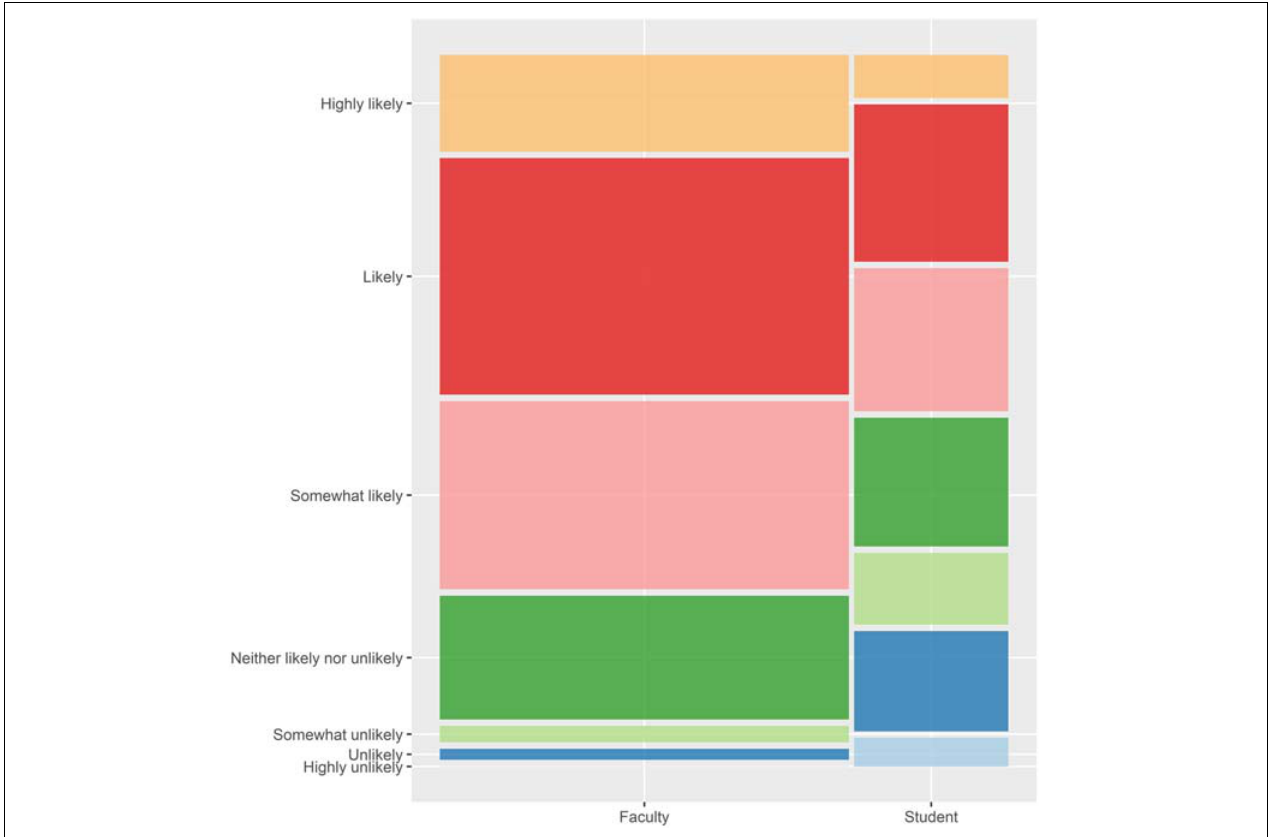
FIGURE 3 | Faculty and student responses to: How likely is it that students who cheat in an academic setting would likely to behave dishonestly in a work